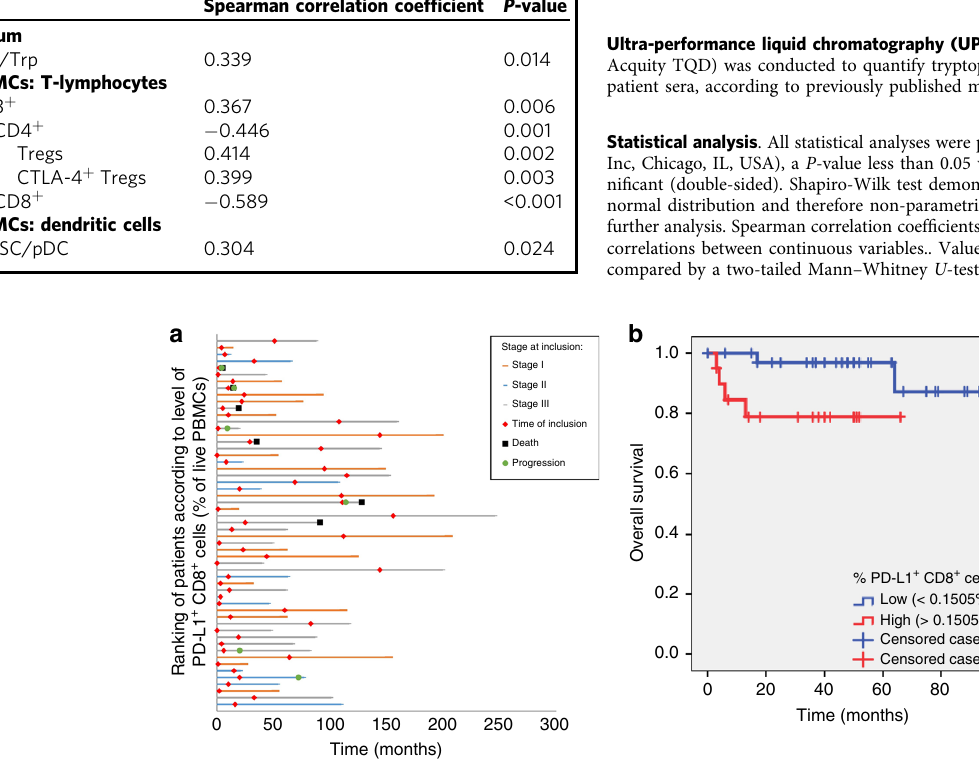
Fig. 1 PD-L1 + CD8 + level according to disease stage and overall survival. Swimmer plot showing the relation between the ranking of PD-L1 + CD8 + cells (according to frequency) and clinical follow-up. b Kaplan – Meier curves of overall survival according to the levels of PD-L1 + CD8 + cells (% of live peripheral blood mononuclear